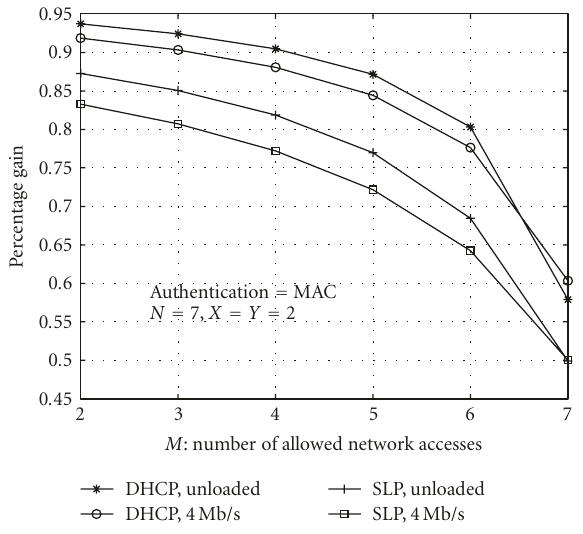
Figure 13: Percentage gain versus M : 802.1X-based authentication.